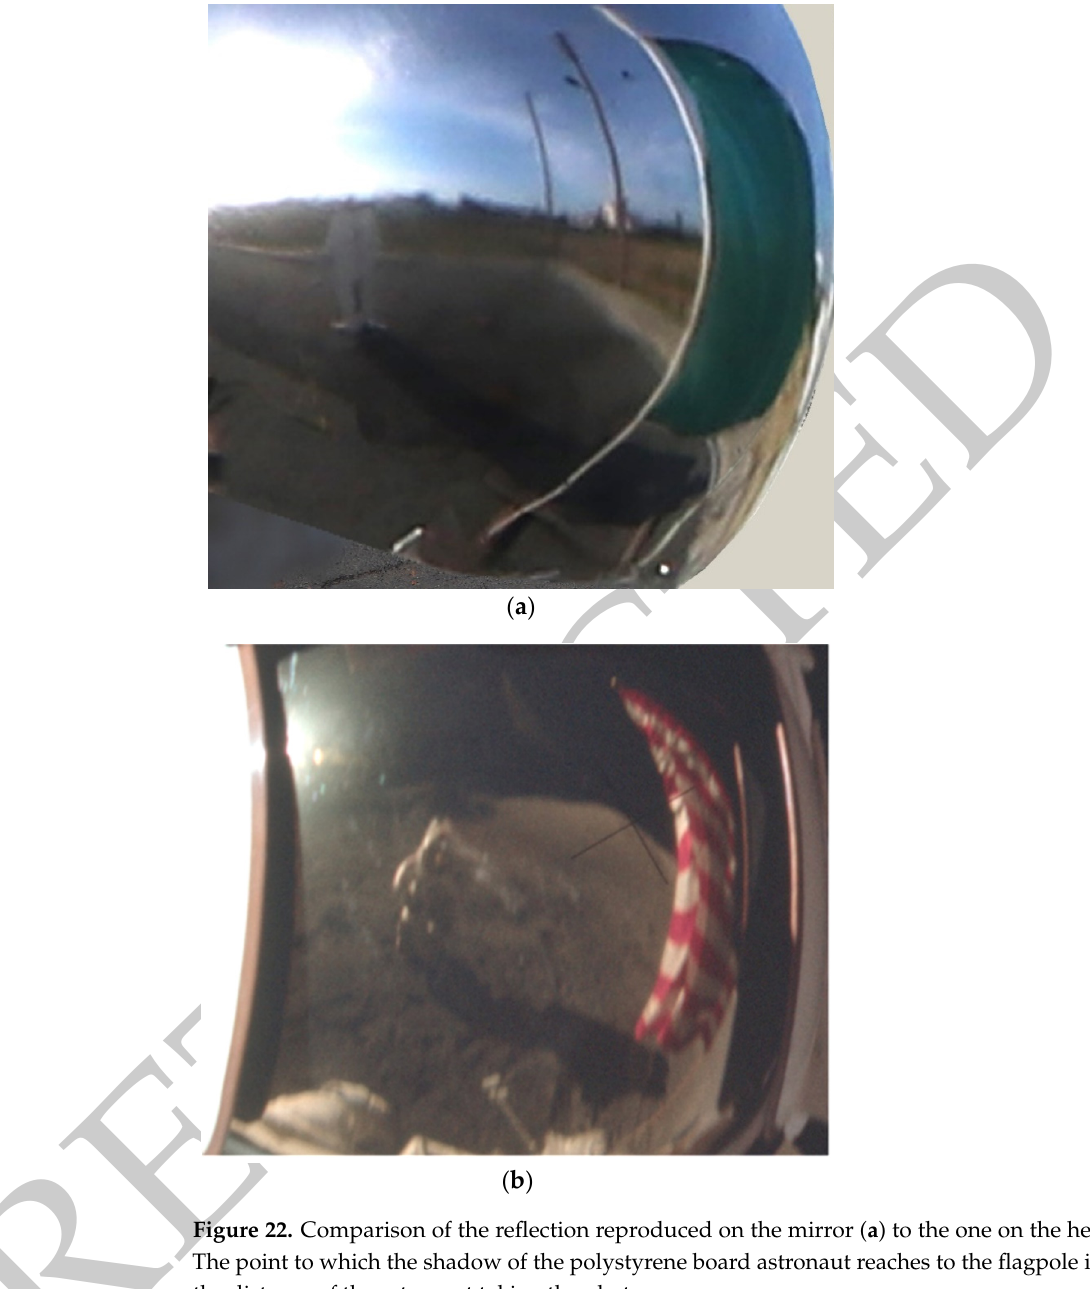
Figure 21. Reproduction: Photographer-astronaut standing at about 3.5 m distance from the flag end along a line running parallel to the length of the flag and about a distance of 0.5 m in ( a ) and 1.1 m in ( b ) between the parallel lines. In both cases, the shadow’s position on the ground is reflected on the helmet (see inset) and is seen to be touching the pole of the flag in its middle part below the flag. For a topographic presentation of the exact points, see also Figure 25, point A for Figure 21a and point B for Figure 21b.